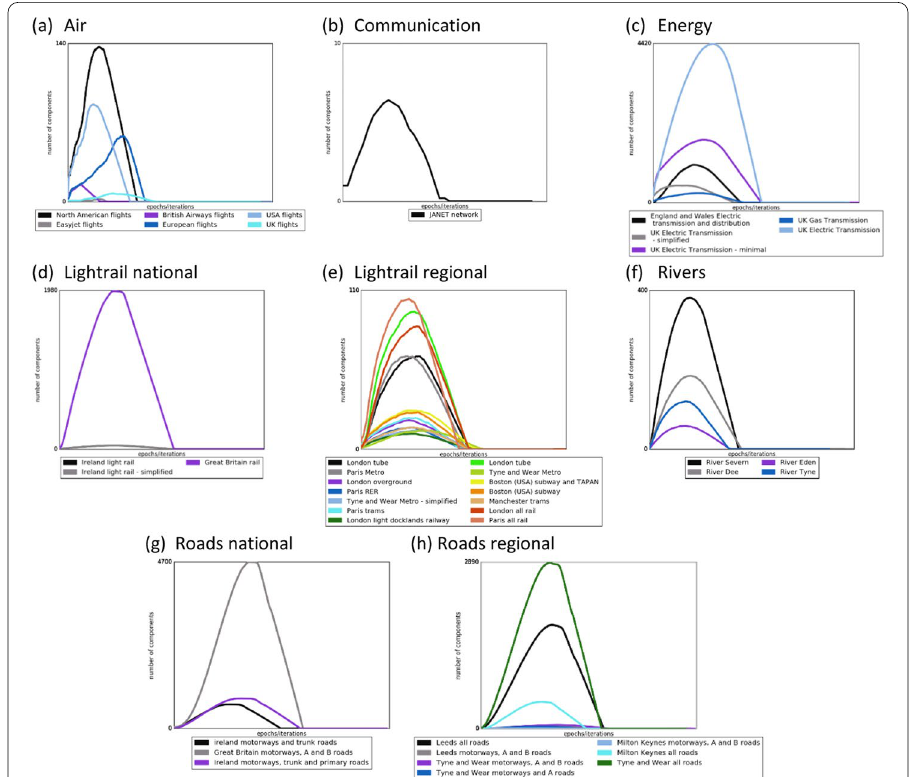
Fig. 12 Failure behaviour of the infrastructure networks under the betweenness failure method. The y-axis shows the number of components and the x-axis shows the % of nodes removed from the graph, with a more robust network showing a smaller peak and towards the left of the